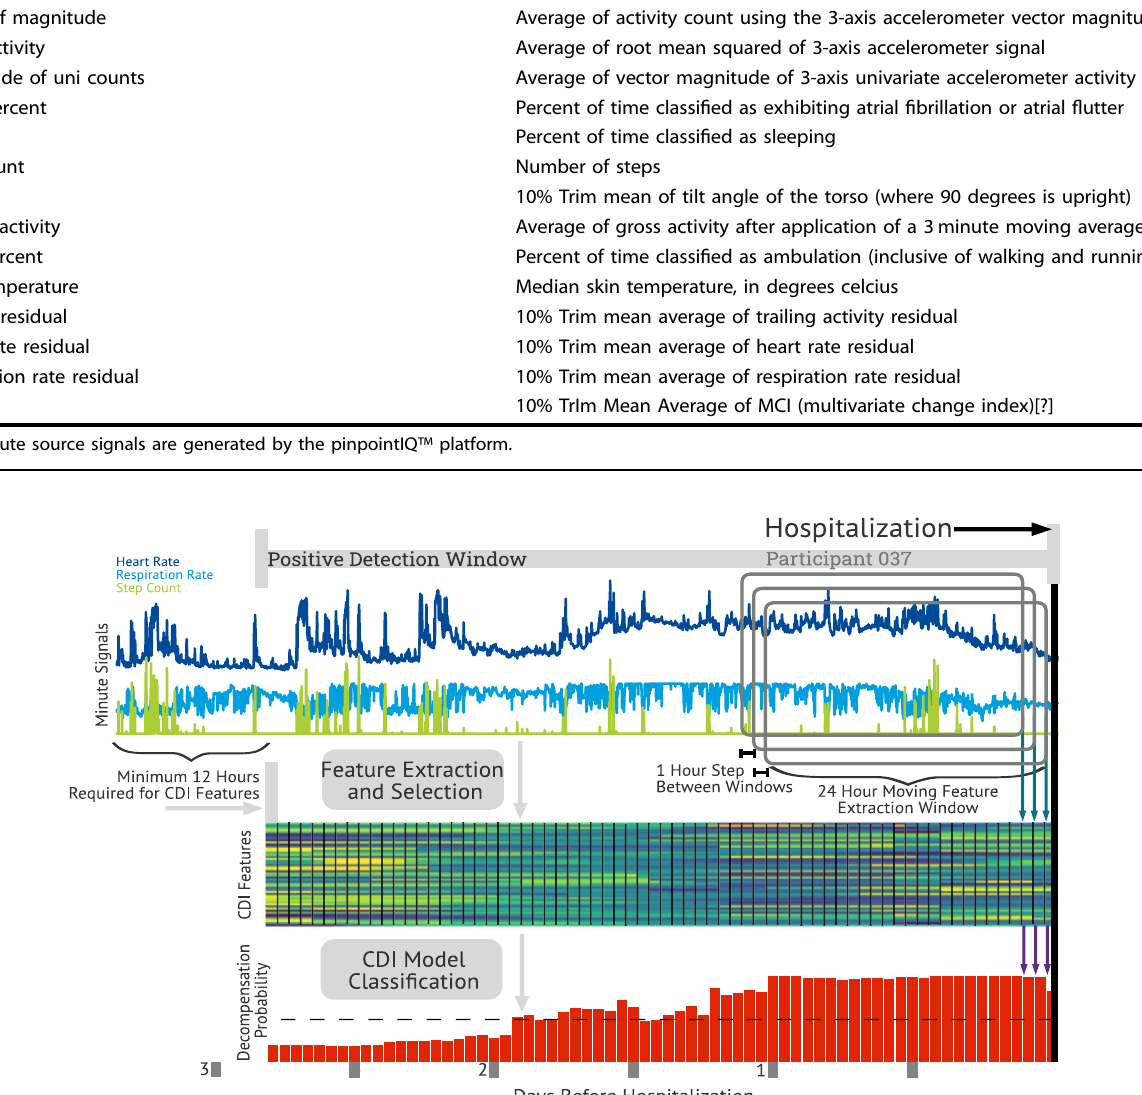
Fig. 6 Processing steps from wearable features to CDI outputs. The source minute features (3 of 17 shown above) are windowed using a moving 24 h window with a 1 h step size. Each windowed set of minute features are processed to produce a feature vector, and timestamped to the end of the 24 h window. Each feature vector is independently passed to the CDI model to produce a decompensation probability at a cadence of once per hour. The positive detection window is de fi ned as up to 14 days before the time of hospitalization and is evaluated at corresponding CDI decisions.